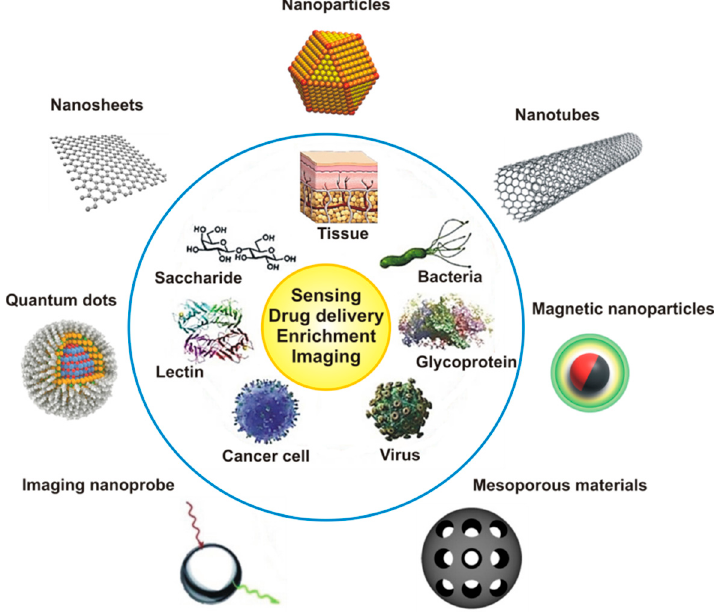
Figure 2. Overview of different nanomaterials (outside the blue circle) used in combination with biomaterials / biomolecules (inside the blue circle) for various applications (in yellow circle). Reproduced with permission from [37]. Copyright Elsevier, 2014. Figure redrawn in our review paper [9], which is an open access article distributed under the terms of the Creative Commons CC BY license.